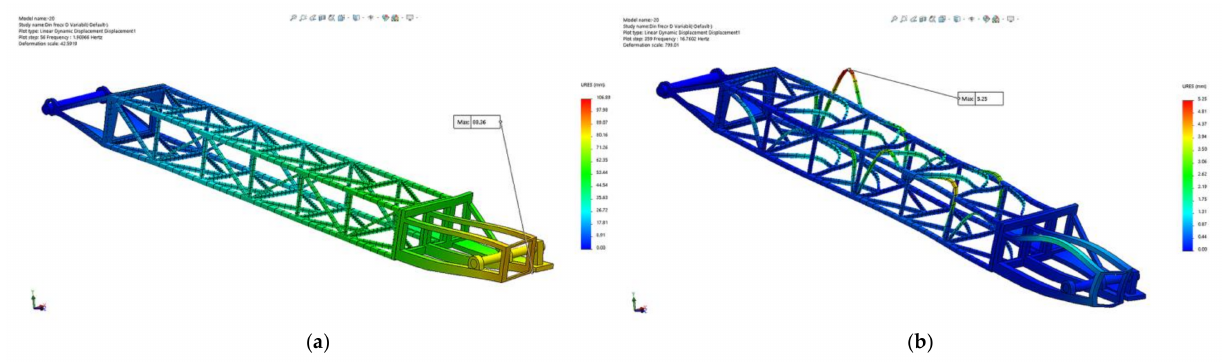
Figure 19. Location and shape of displacement of the boom for the lowest possible excavation position, under the bench (3). ( a ) Mode 2, frequency of 1.91 Hz; ( b ) Mode 12, frequency of 16.76